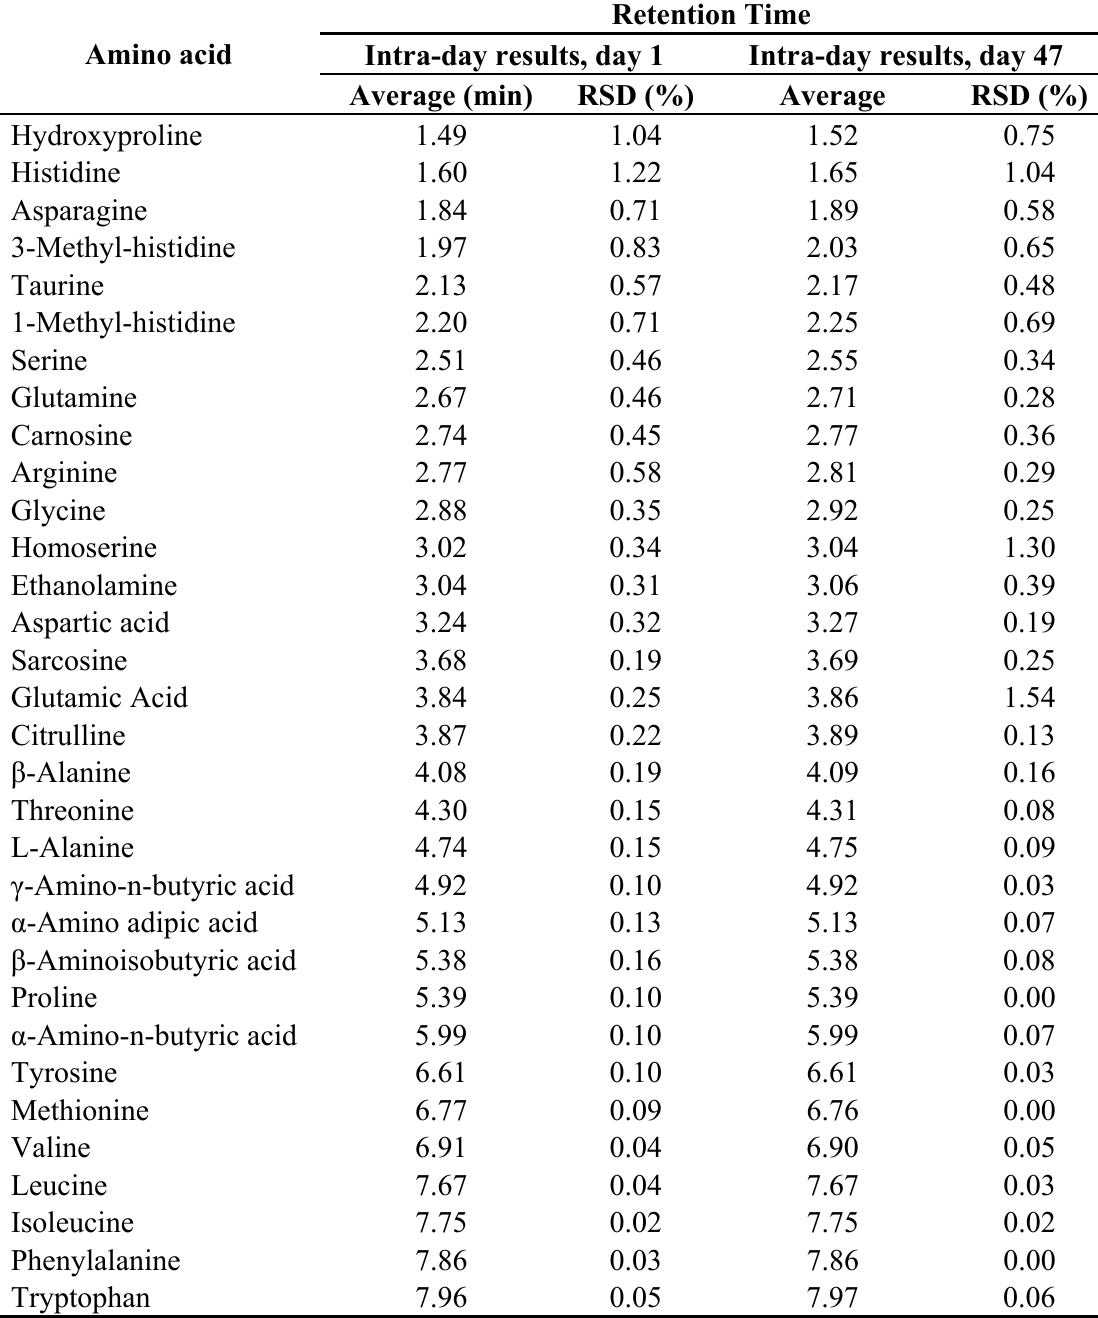
Table S2. Long term repeatability of retention times for AQC-derivatized amino acids in standard solutions analyzed by UPLC-ESI-MS/M (n =